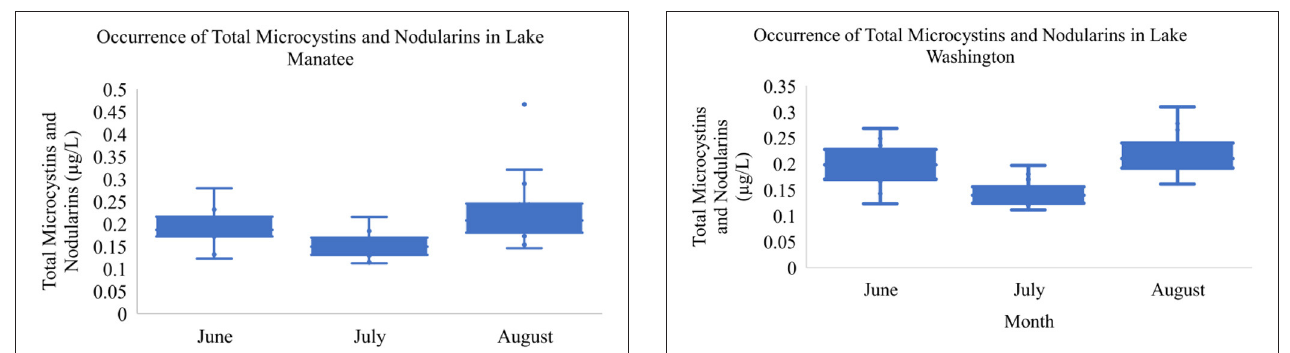
FIGURE 3 | Occurrence of total microcystins and nodularins in Lake